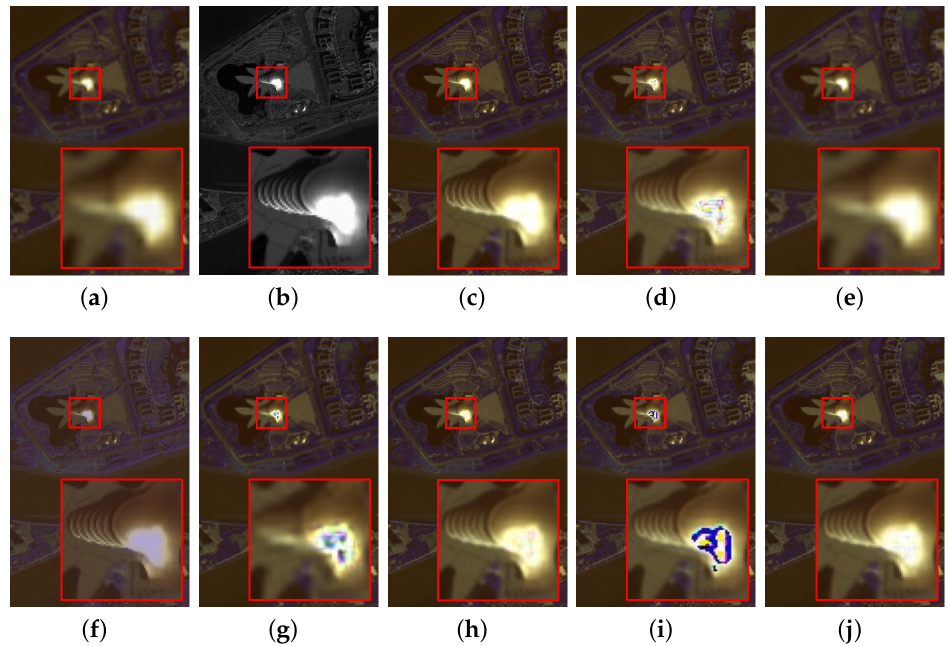
Figure 5. Comparison results obtained by different methods (downsampled GF-2 image of Guangzhou Province, China). ( a ) LRMS image. ( b ) HRPAN image. ( c ) Reference MS image. ( d – j )